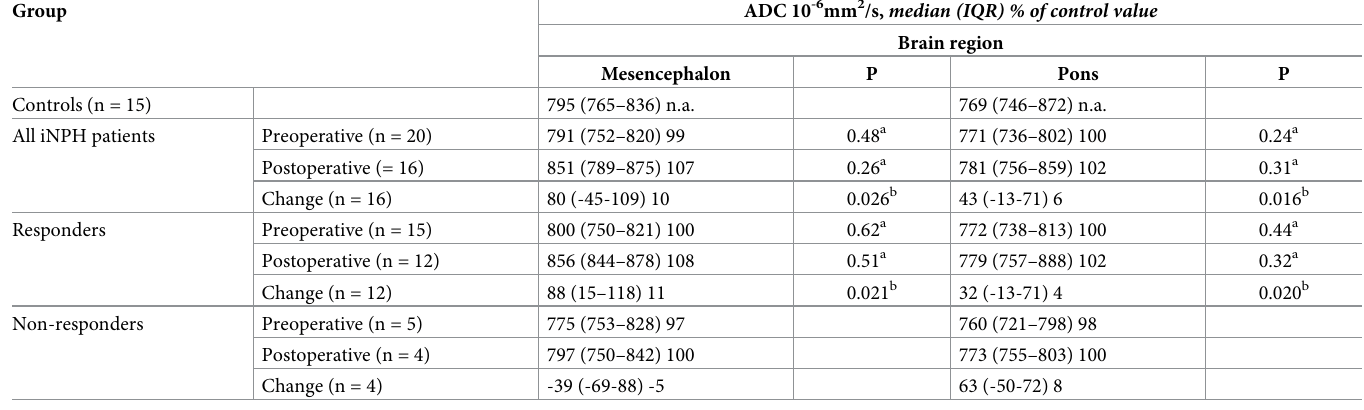
Table 2. Apparent diffusion coefficient (ADC) values in controls and iNPH patients given for the composite ROI in the mesencephalon and pons.